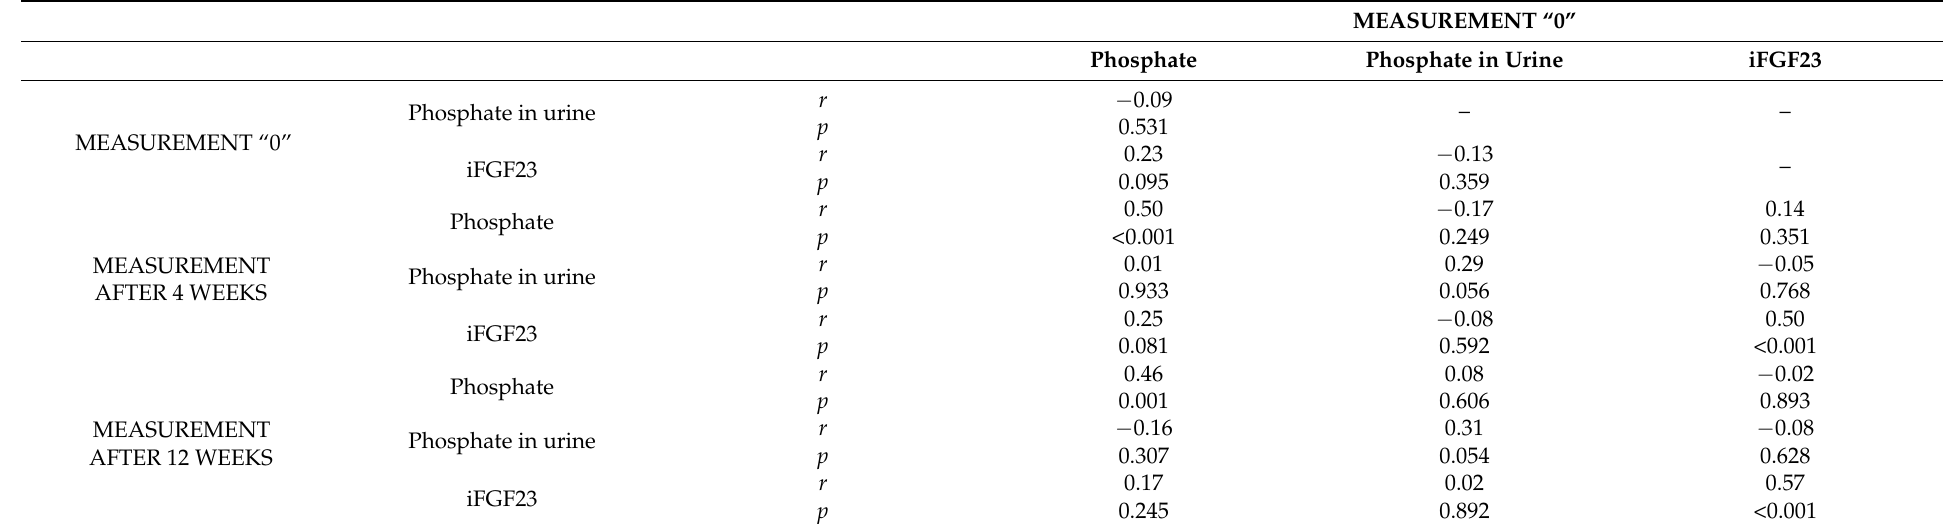
Table 5. Relationship of phosphate and iFGF23 levels in individual measurements.